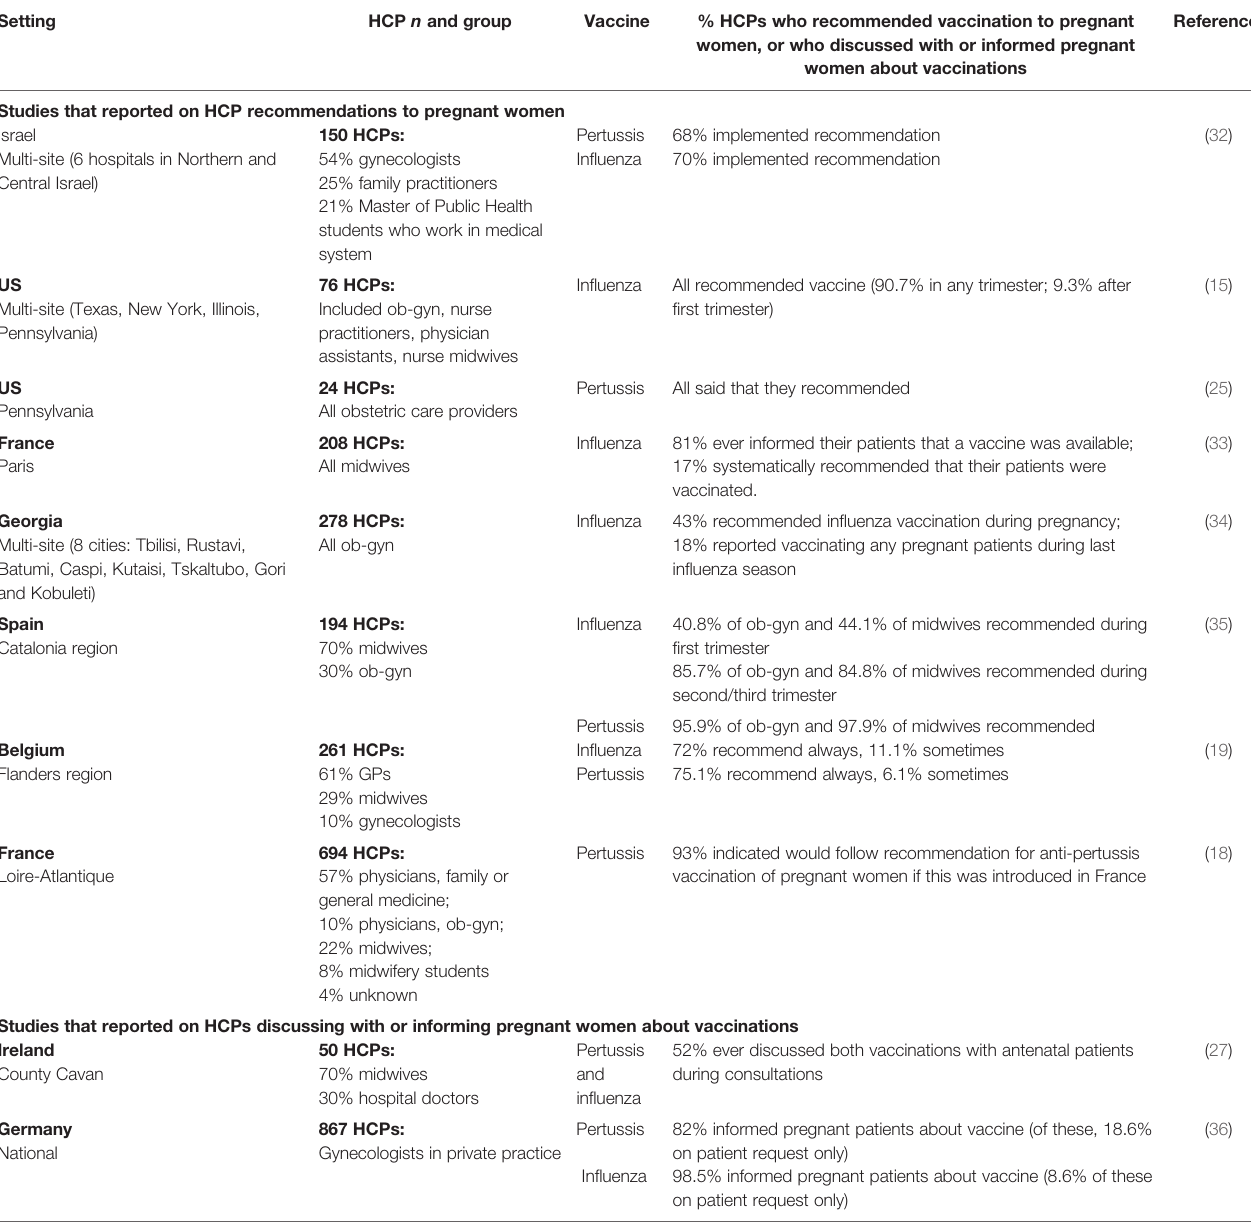
TABLE 1 | Self-reported behavior of HCPs in recommending in fl uenza and pertussis vaccinations to pregnant women, or discussing with or informing pregnant women about these vaccinations. Setting HCP n and group Vaccine % HCPs who recommended vaccination to pregnant women, or who discussed with or informed